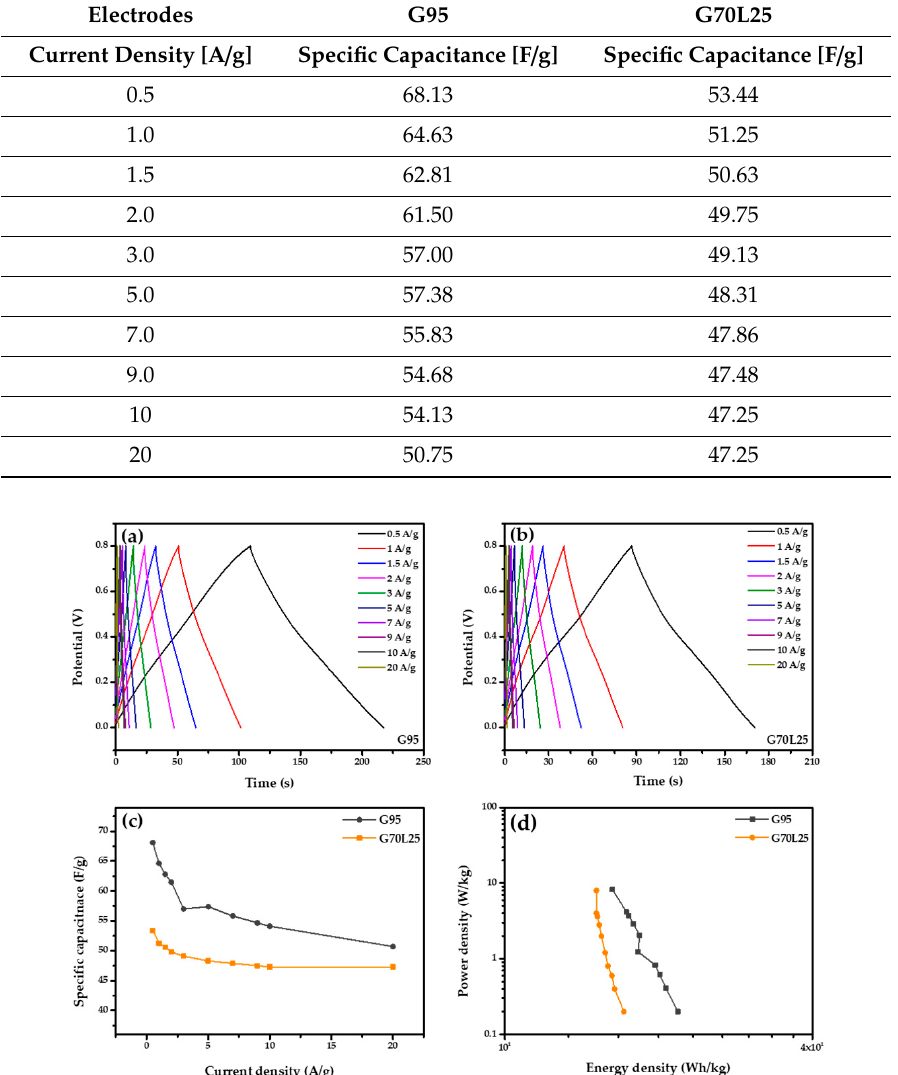
Figure 7. Galvanostatic charge-discharge graph of ( a ) G95 electrode and ( b ) G70L25 electrode; ( c ) specific capacitance variation of G95 and G70L25 with current density; ( d ) comparative Ragone plots of the G95 and G70L25 electrodes. Table 1. The specific capacitance of G95 and G70L25 according to current density.